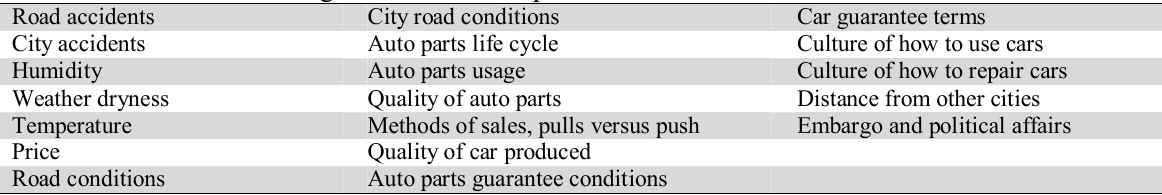
Different factors influencing demand for auto parts